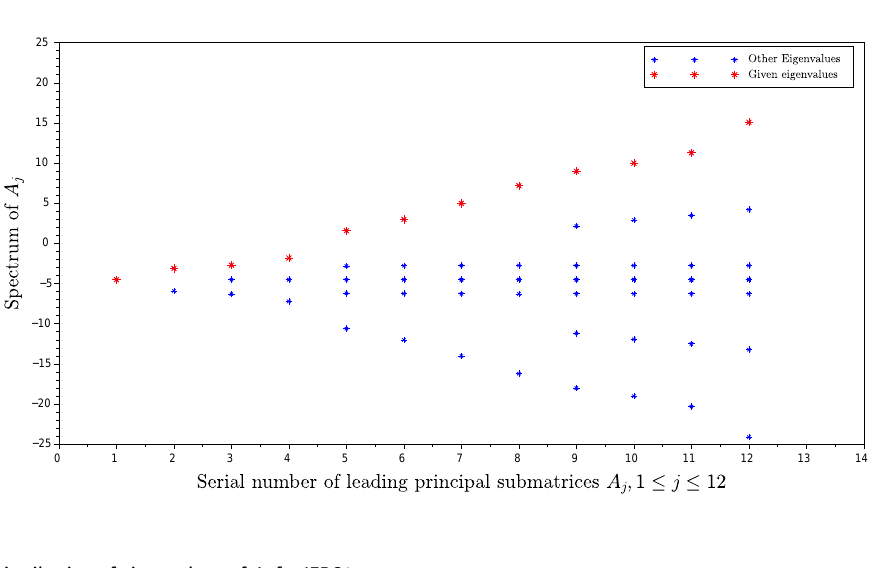
Figure 5: Distribution of eigenvalues of A j for